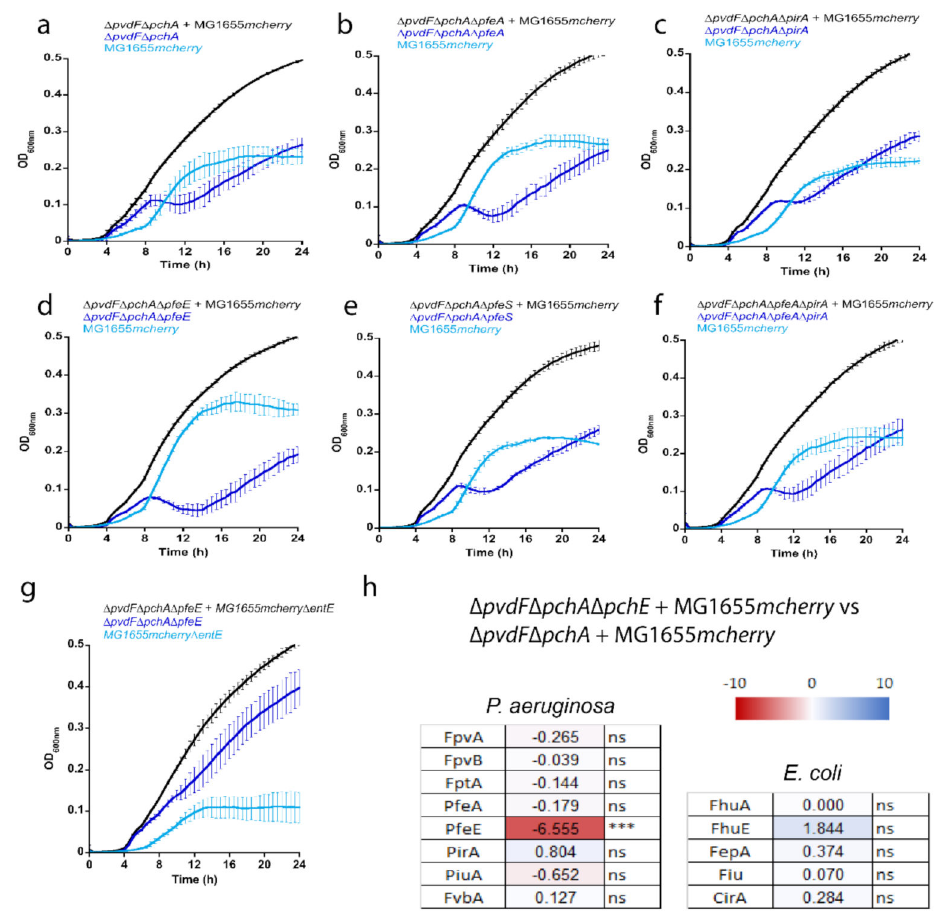
Figure 6. Co-cultures between E. coli MG1655 mcherry and mutants of the ENT pathway of P. aeruginosa . ( a – f ) Co-cultures between E. coli MG1655 mcherry and P. aeruginosa strains unable to produce PVD and PCH ( ∆ pvdF ∆ pchA ) and deleted for one of the genes of the ENT pathway ( pfeA , pirA , pfeE , or pfeS ). ( g ) Growth of E. coli MG1655 mcherry ∆ entE and ∆ pvdF ∆ pchA ∆ pfeE . All co-cultures in panels ( a – g ) were carried out in CAA medium supplemented with 0.6% glycerol at 30 ◦ C and both strains were mixed at an OD 600 nm of 0.005. Bacterial growth was followed by monitoring the OD at 600 nm. As in Figures 4 and 5, MG1655 mcherry carries a plasmid encoding mCherry and the fluorescence of this protein was followed at 610 nm (excitation: 570 nm). These values at 610 nm were used to identify the portion of the OD signal at 600 nm in the co-cultures due to E. coli and P. aeruginosa . All the data are the means of three independent experiments. ( h ) Differential proteomic analyses were performed on P. aeruginosa and E. coli proteomes between co-cultures presented in panel ( d ) and those presented in panel ( a ) Heat maps: darker shades of blue indicate higher expression of the protein; darker shades of red indicate greater repression of expression of the protein. *** p < 0.001. For P. aeruginosa , FpvA and FpvB are the outer membrane transporters of ferri-PVD, FptA of ferri-PCH, PfeA and PirA of ferri-ENT, PiuA and FvbA of ferri-catechol-type siderophores, and, finally, PfeE is the esterase of the ENT pathway [25]. For E. coli , FepA is the outer membrane transporter of ferri-ENT, Fiu and CirA of other ferri-catechol siderophores, and FhuA and FhuE of hydroxamate